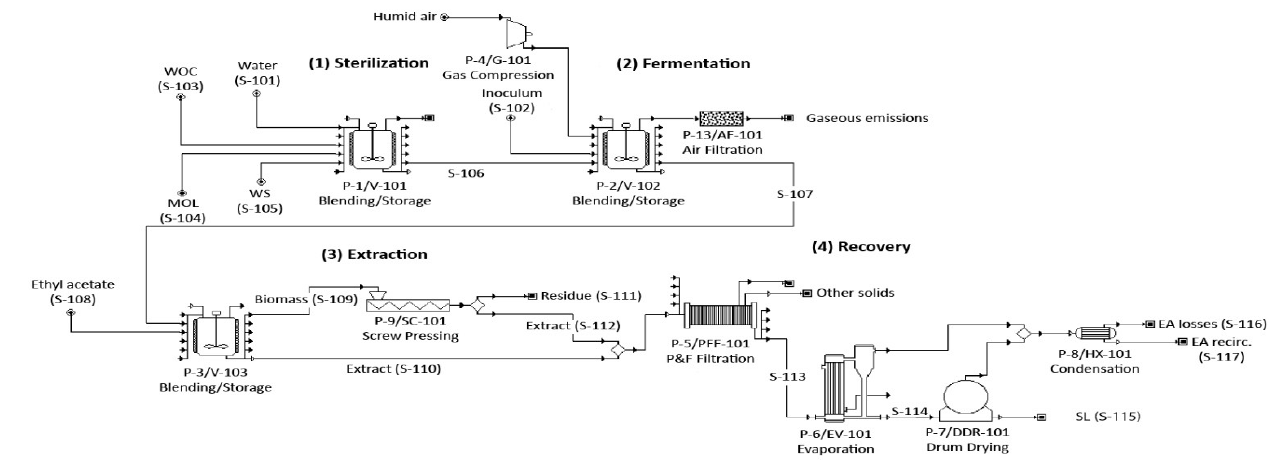
Figure 1. Flow diagram for SL production from WOC by solid-state fermentation and by organic solvent recovery. Nomenclature: WOC: winterization oil cake, MOL: molasses, WS: wheat straw, EA: Ethyl acetate, SL: sophorolipids.